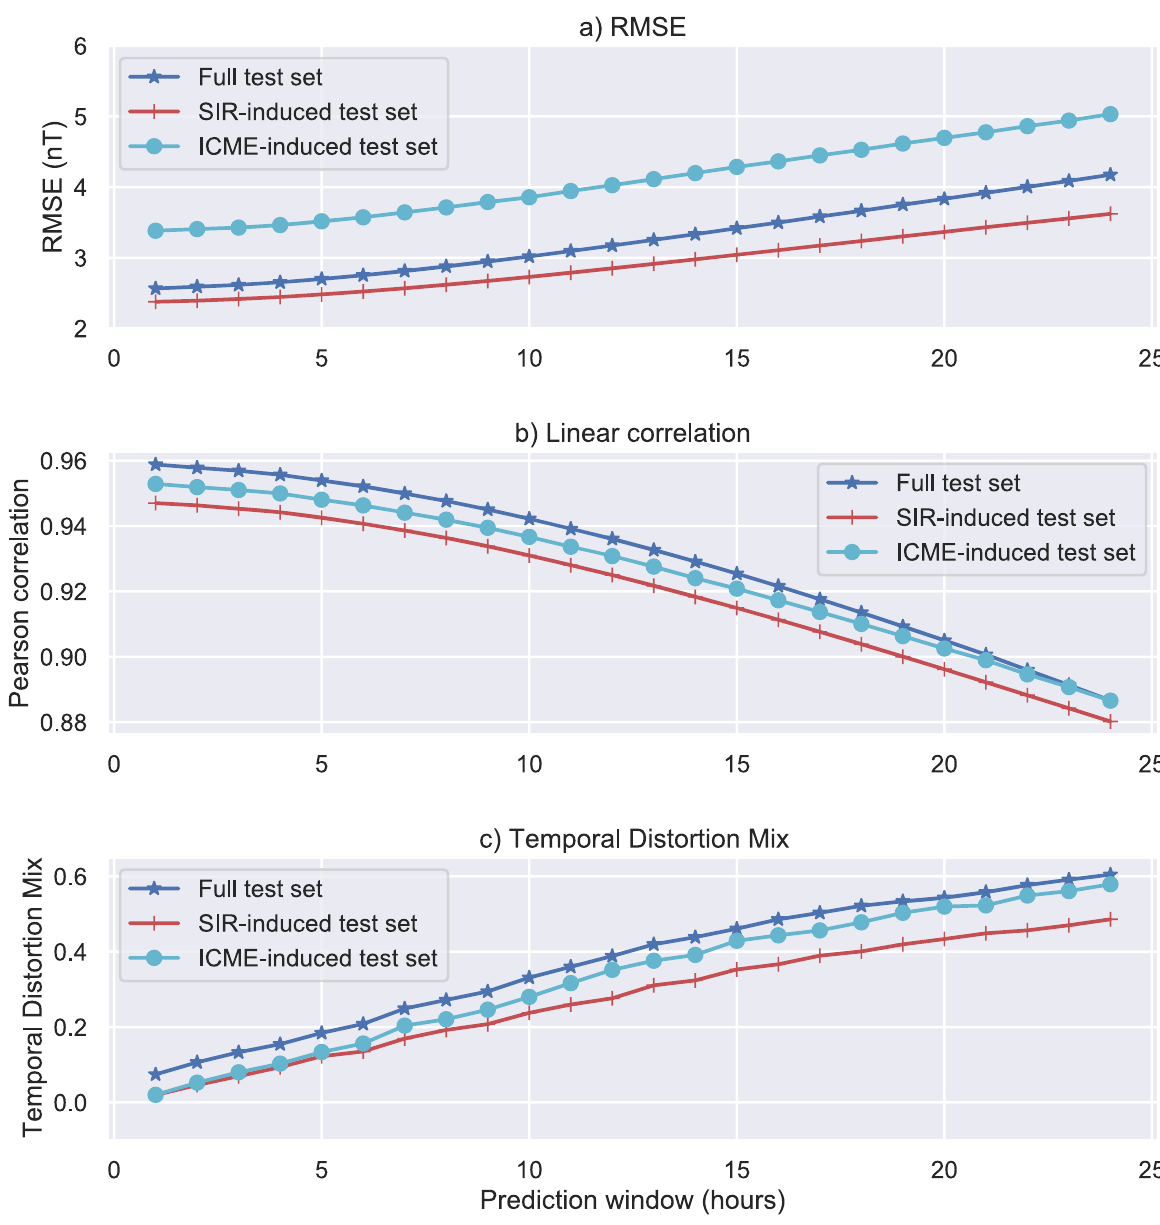
Fig. 5. Evaluation of the LSTM-NN model with three measures (RMSE, R and TDM) for values of time horizon ranging from 1 h to 24 h. Three evaluation sets (full test set, SIR-induced set and ICME-induced set) were